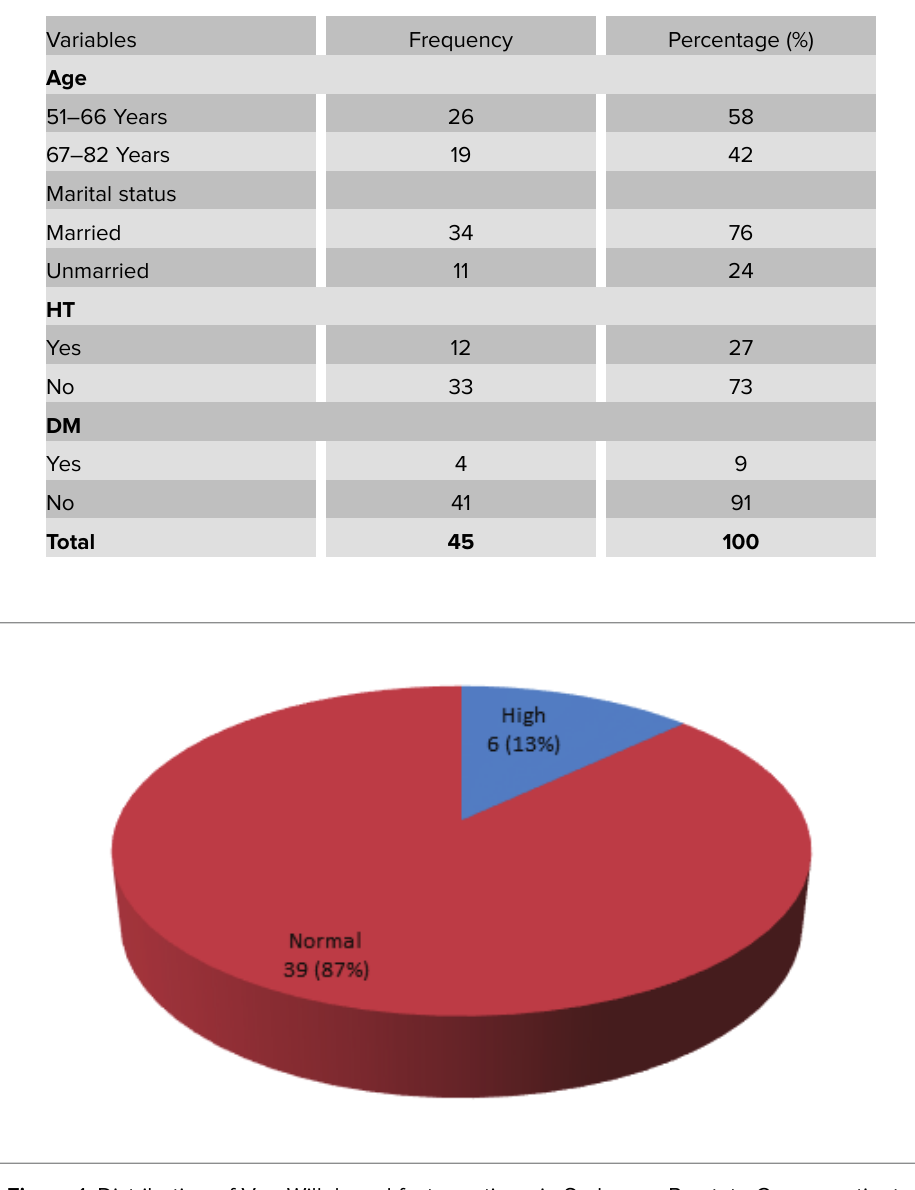
Figure 1: Distribution of Von Willebrand factor antigen in Sudanese Prostate Cancer